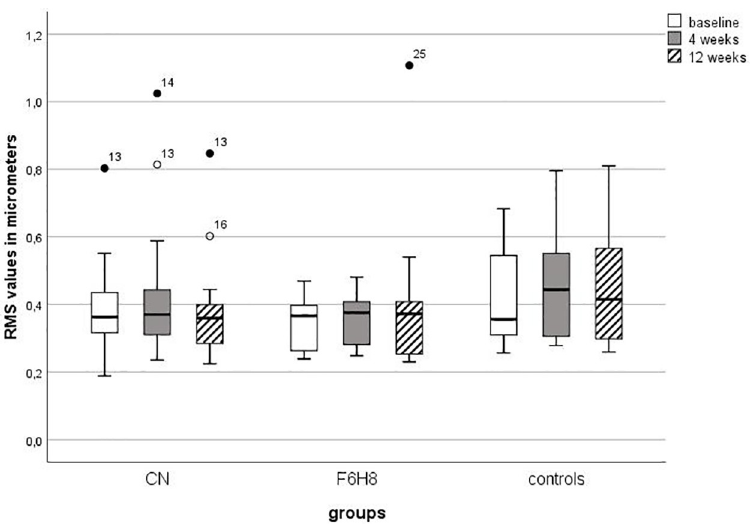
Fig 5. RMS values (in μ m) at baseline and consecutive measurements. The RMS values at 4 and 12 weeks were compared with the values of the baseline using the Wilcoxon test. All p-values were adjusted for 2 comparisons according to the Bonferroni method. An asterisk with the corresponding p-value indicates a significant change compared to the baseline. RMS = Root Mean Square; μ m = micrometer; CN = cationic nanoemulsion; F6H8 =